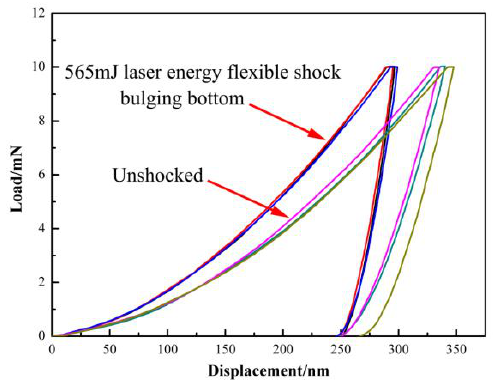
Figure 13. The nanoindentation load-displacement curve of 304 stainless steel foil with 40 µm before and after laser flexible shock.